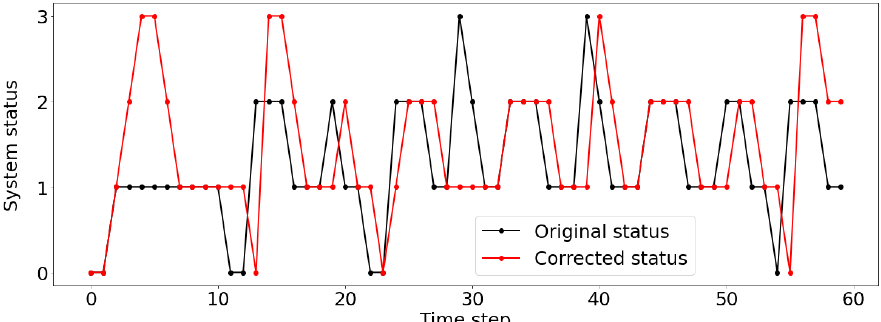
Figure 10. The system status for a sample of the data set, as given in the data set and by its correction using the rules established in Section